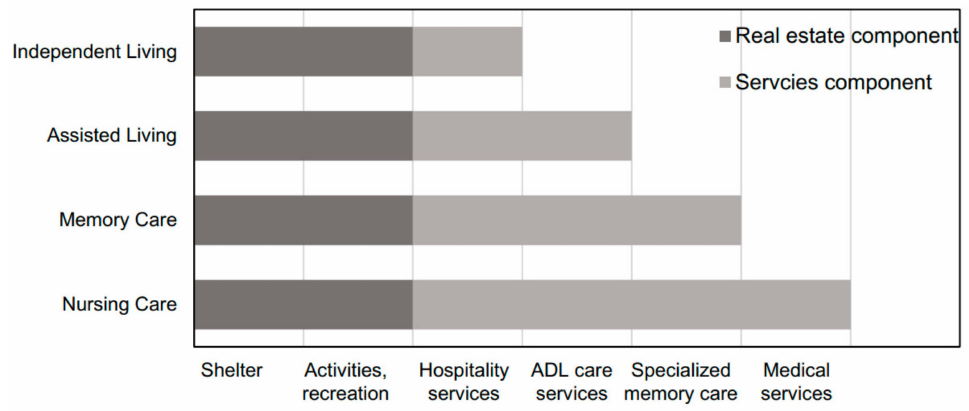
Figure 1. Senior housing property types by care segments (adapted from NIC [9]).